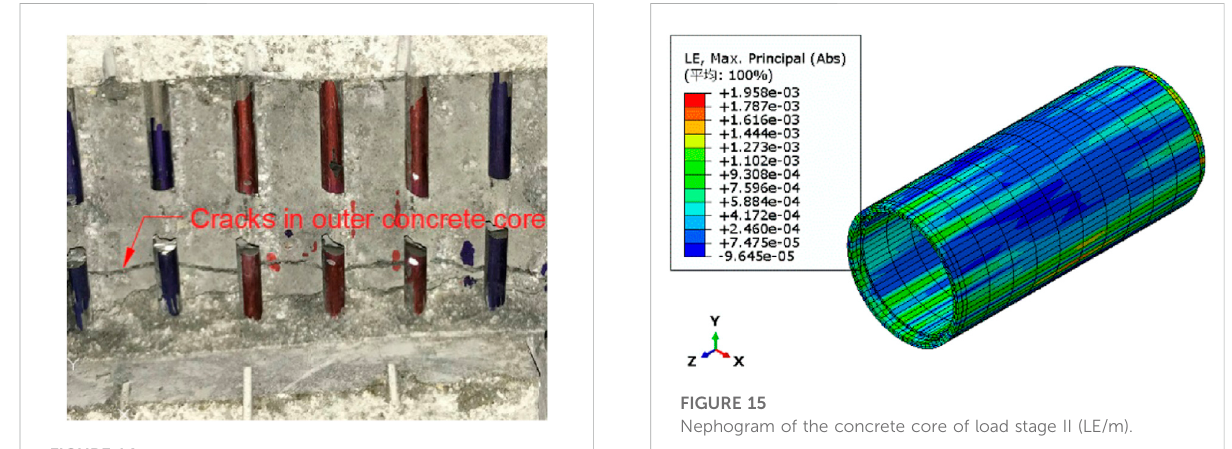
FIGURE 14 Distribution of cracks in the outer concrete core.